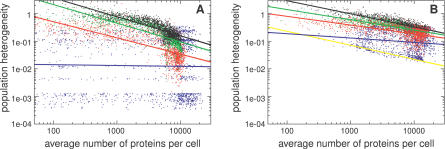
Population Heterogeneity As a Function of Protein Number, Both for the Deterministic and Stochastic Simulations(A) Population heterogeneity in the deterministic simulations, expressed as standard deviation/mean of the number of β-galactosidase proteins per cell. Different colors represent different simulations. All dots indicate the population heterogeneity at certain equally spaced timepoints. Solid lines give the result of a power-law regression between these dots. Black: an evolutionary simulation in a spatial environment, both genetic and spatial heterogeneity, evolutionary timescale. Red: an evolutionary simulation in a well-mixed environment, genetic heterogeneity, but no spatial heterogeneity, evolutionary timescale. Green: a simulation with one clone (the last common ancestor of the “black” simulation), spatial heterogeneity, but no genetic heterogeneity, physiological timescale. Blue: a simulation with one clone (the last common ancestor of the “red” simulation), no spatial heterogeneity, no genetic heterogeneity, physiological timescale.(B) Population heterogeneity in the stochastic simulations. All colors are as in Figure 2A, except yellow: regression curve of intrinsic noise versus average protein number (from Figure 1).